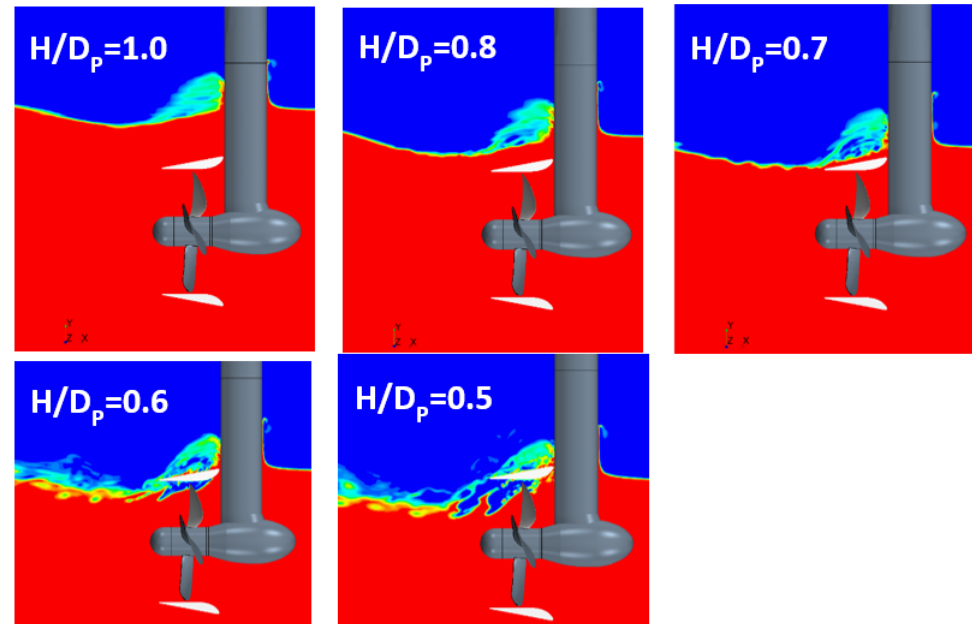
Figure 21. Ventilation inception with decrease in propulsor submergence, H/Dp, at J = 0.6.